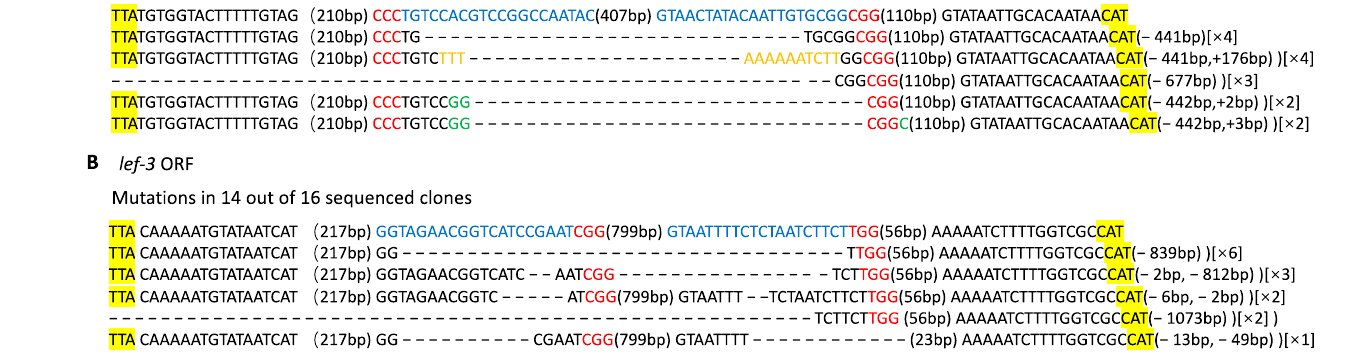
Figure 3. CRISPR/Cas9-mediated BmNPV genome editing in transgenic silkworms. Mutations detected in ( A ) lef-1 and ( B ) lef-3 in TG-1 silkworms inoculated with 10 6 OBs/larva. For each gene, the open reading frame in the WT sequence is shown at the top with the start and stop codons highlighted in yellow, the target sites in blue, and the PAM sequences in red. The net change in length caused by each indel mutation is given to the right of the sequence (+, insertion; − , deletion). The number of times each mutant clone was isolated is shown in brackets.